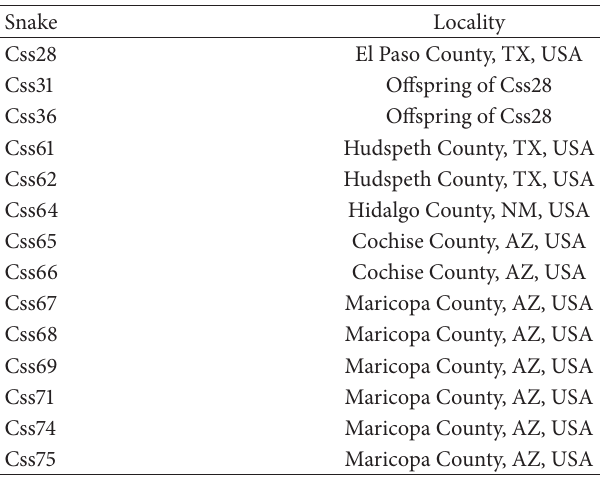
Table 1: Geographical data of Mojave rattlesnakes captured for this